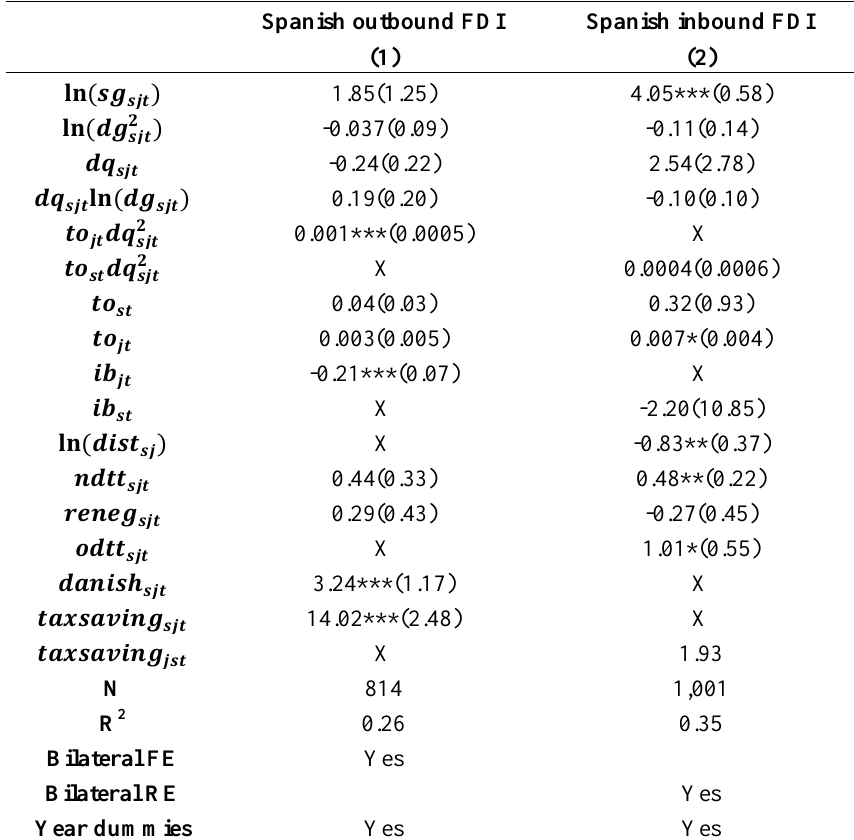
Table 6 : Effect of DTTs and the Territorial Tax System on Spanish inbound and outbound